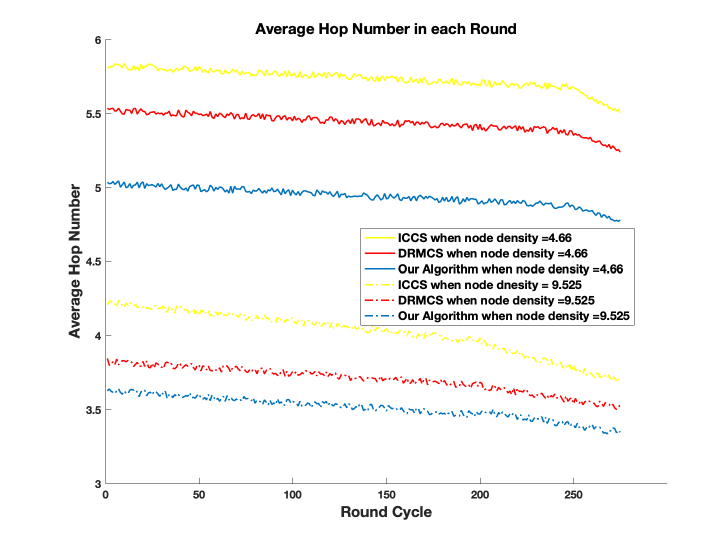
Figure 11. The comparison results in terms of average hop numbers with two different node